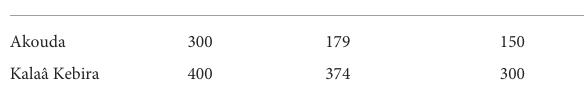
TABLE 3 Distribution of irrigated areas (private) per municipalities (ha). Municipality Irrigable Irrigated areas Cultivated areas